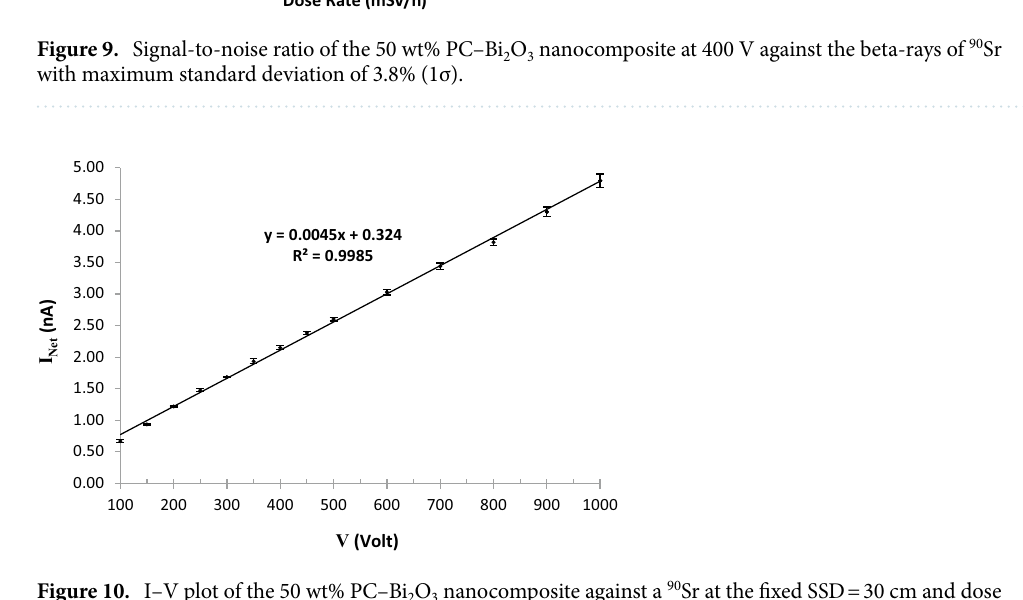
Figure 10. I–V plot of the 50 wt% PC–Bi 2 O 3 nanocomposite against a 90 Sr at the fixed SSD = 30 cm and dose rate of 102.436 mSv h −1 , with maximum standard deviation of 3.8%